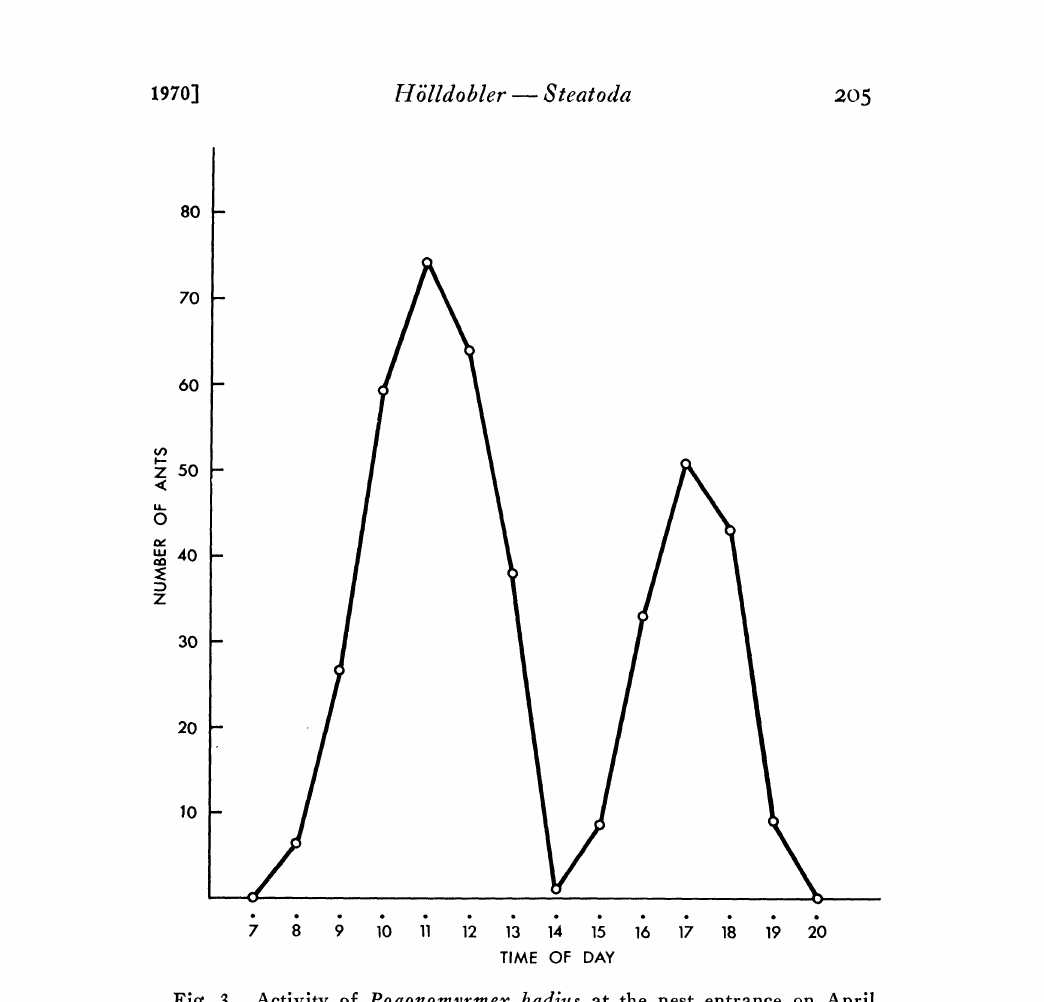
Fig. 3. Activity of Pogonomyrmex badius at the nest entrance on April 11, 1970, near Tampa, Florida. Abscissa: average number of ants passing through nest entrance during one minute observation periods. Ordinate" time of